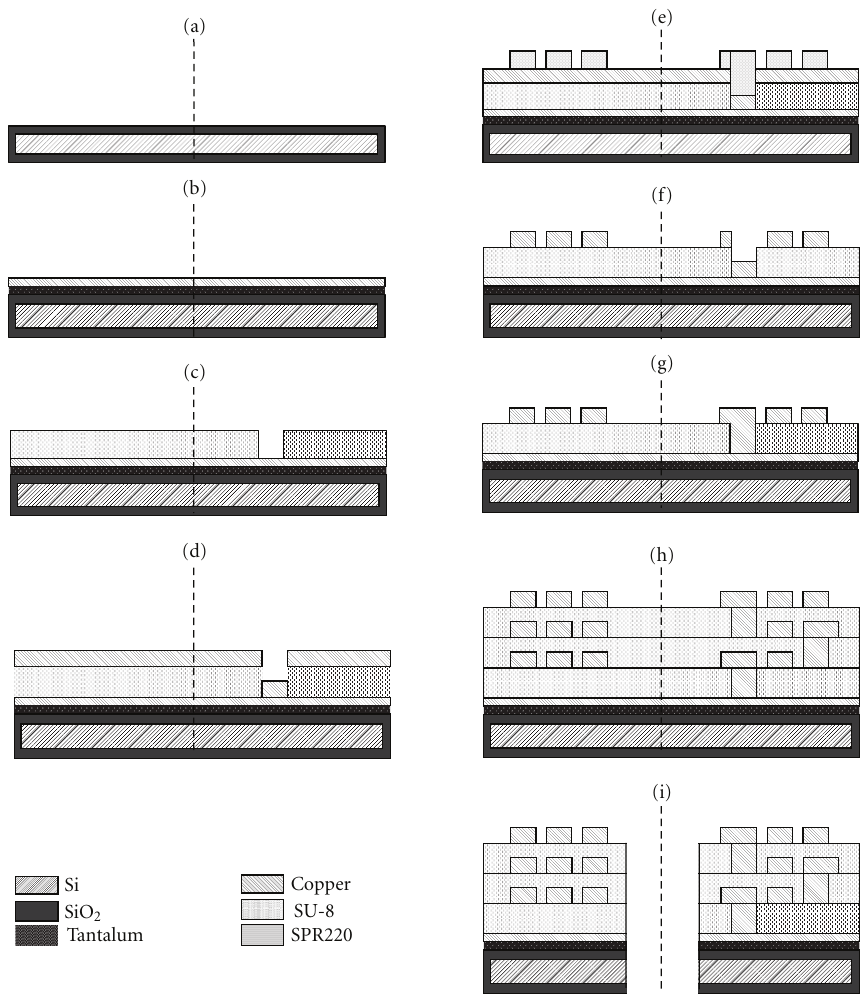
Figure 4: Simplified fabrication process. Note not drawn to scale in order to show